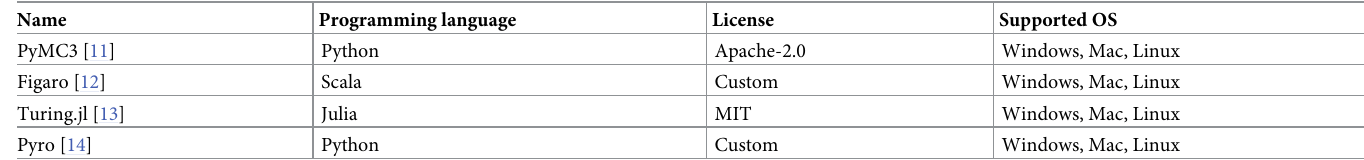
Table 1. Basic characteristics of probabilistic programming